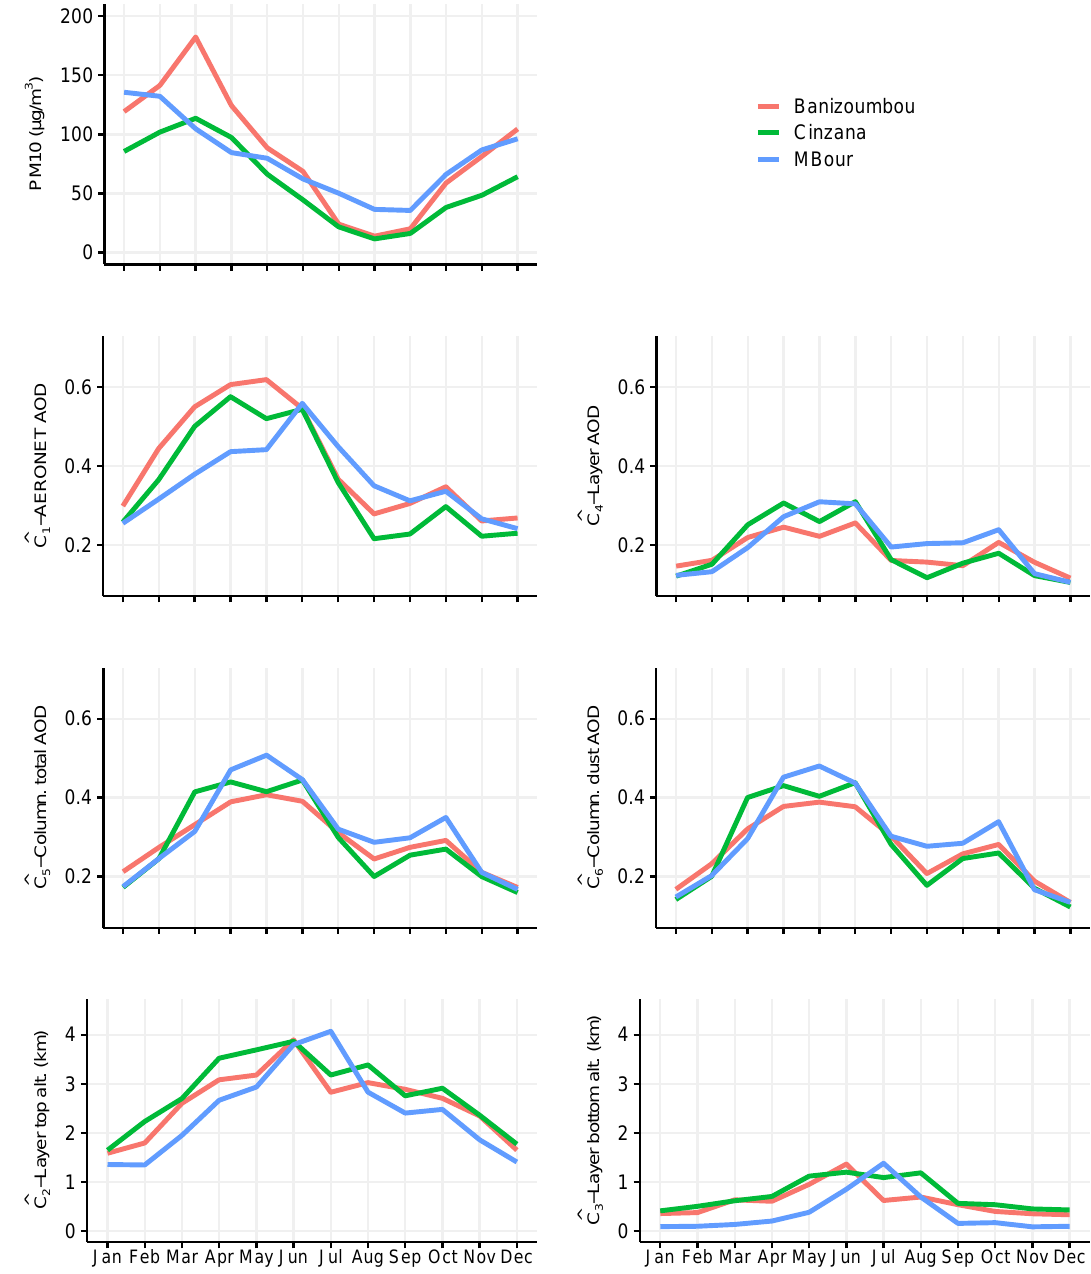
Figure 3. Monthtly mean annual cycle of PM10, ( ˆ C 1 ) AERONET AOD and ( ˆ C 5 ) CALIOP columnar total and ( ˆ C 6 ) columnar dust AOD, ( ˆ C 2 ) top and ( ˆ C 3 ) bottom altitude and ( ˆ C 4 ) AOD of the lowermost dust